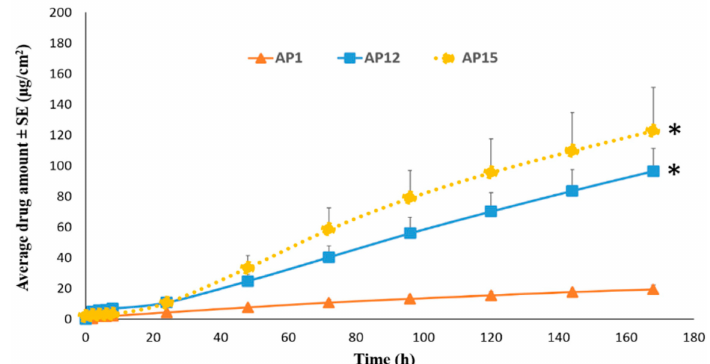
Figure 6. Permeation profile of acrylate based TAF patches comprising of oleyl alcohol and comparison with the control patch through human epidermis. * Represents statistically significant difference, ANOVA one way test ( p < 0.05). AP1: Acrylate based patch containing 2% TAF and 5% oleic acid. AP12: Acrylate based patch containing 2% TAF, 5% oleic acid, 5% PG, and 5% oleyl alcohol. AP15: Acrylate based patch containing 2% TAF, 5% PG, and 10% oleyl